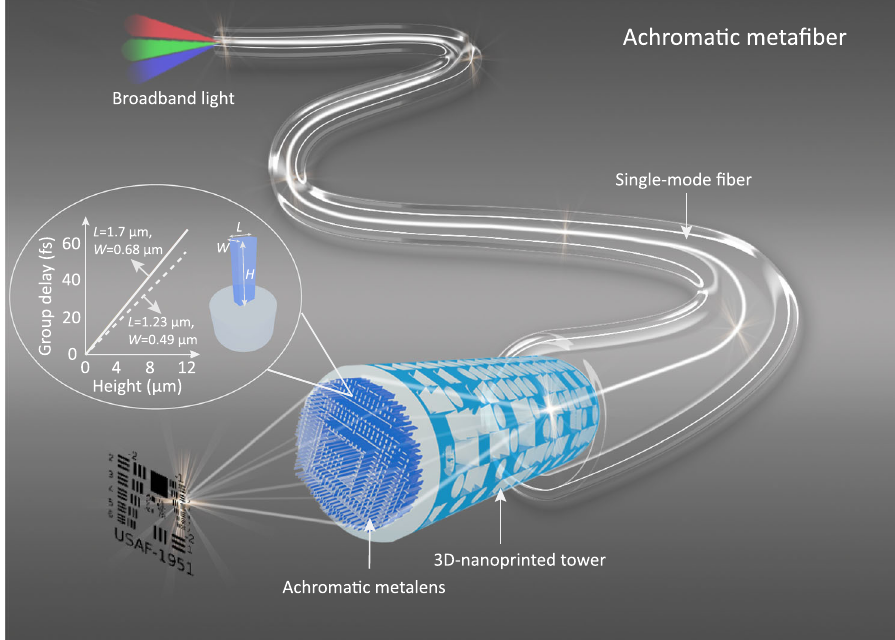
Fig. 1 Principle of an achromatic meta fi ber used for achromatic focusing and imaging. An achromatic metalens located on top of a 3D-printed hollow tower (used for fi ber-beam expansion) was interfaced with a single-mode fi ber via 3D laser nanoprinting. Inset: an enlarged 3D nanopillar meta-atom (height: H , length: L , width: W ), the height of which offers a large modulation range of group